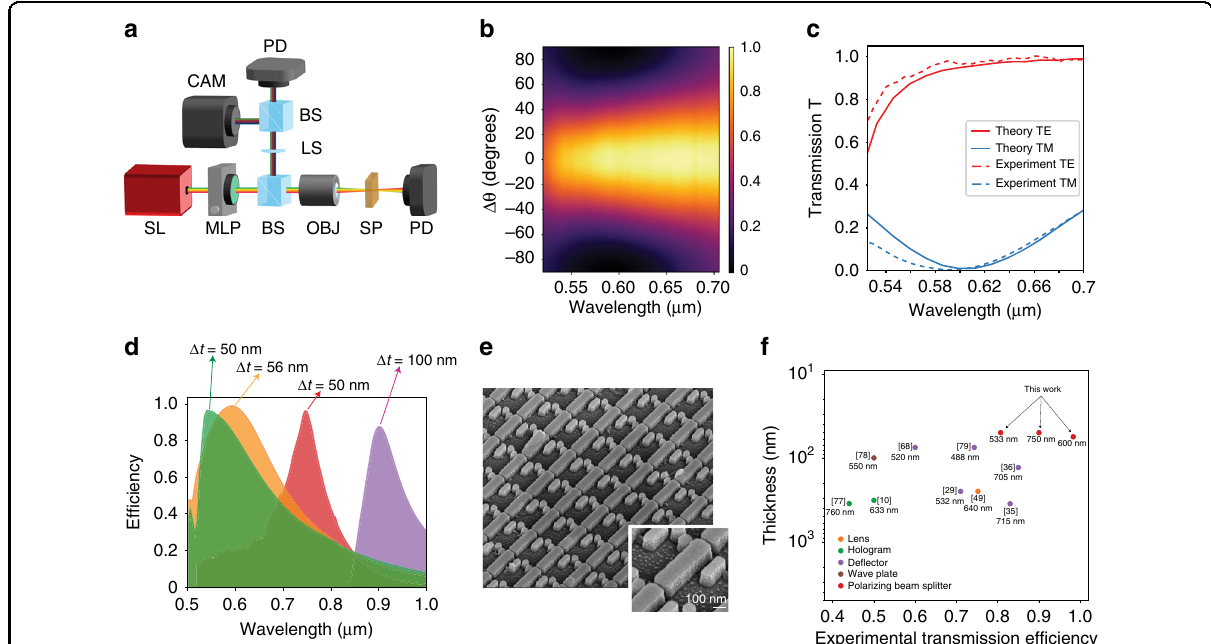
Fig. 3 Experimental results for polarizing beam splitters. a Experimental setup used to characterize the samples (SL: supercontinuum laser, MLP: motorized linear polarizer, BS: beam splitter, LS: lens, OBJ: objective, CAM: CMOS camera, PD: calibrated photodetector, SP: sample). b Transmission ef fi ciency of the 600 nm polarizer for different wavelengths and input polarization angles Δ θ . c Comparison between theory (solid line) and experiment (dashed line) for the 600 nm polarizer transmission curves. d Experimentally measured polarization ef fi ciencies at different wavelengths for four different samples working around the common laser line wavelengths of 533, 600, 750 and 900 nm. e SEM images of a characteristic sample for the polarizer designed at 900 nm. f Silicon-based fl at-optics state of the art in the visible range. The fi gure presents the experimentally measured transmission ef fi ciency for previously reported devices in the visible region and for this